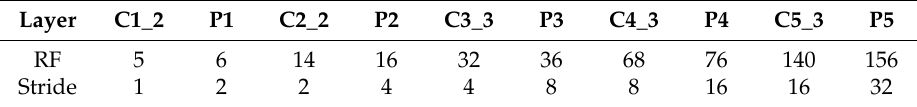
Table 2. The receptive field (RF) and stride size of the VGG16 used in